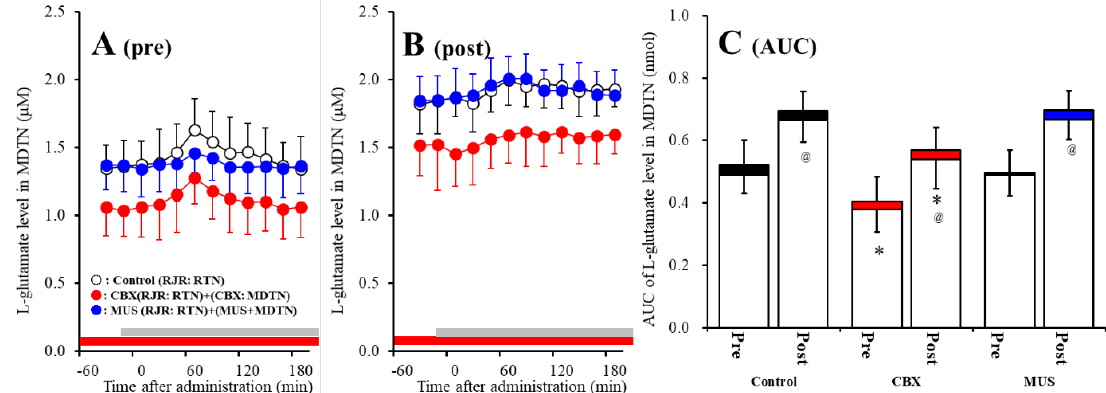
Figure 7. E ff ects of local administration of 100 µ M CBX (non-selective hemichannel inhibitor) and 1 µ M MUS (GABA A receptor agonist) into the MDTN on pre-RJR- (panel A ) and post-RJR-evoked (panel B ) l -glutamate release (before and after hemichannel activation induced by perfusion with FCHK-MRS into the MDTN for 20 min) in the MDTN of S286L-TG. Ordinates indicate mean the extracellular l -glutamate level ( µ M) (N = 6), and abscissas indicate time after RJR-evoked stimulations (min). Gray bars indicate the perfusion with 100 µ M RJR2403 into the RTN. Red bars indicate the perfusion with 100 µ M CBX or 1 µ M MUS into the MDTN. (Panel C ) indicates the AUC value of the extracellular l -glutamate level (nmol) before (basal extracellular l -glutamate level) and after RJR-evoked stimulation (from 20 to 180 min) of panels ( A , B ). Opened columns indicate the AUC values of basal extracellular levels of l -glutamate in panel A and B. * p < 0.05 relative to control, @ p < 0.05 relative to before hemichannel activation (pre) by MANOVA with Tukey’s post hoc test.